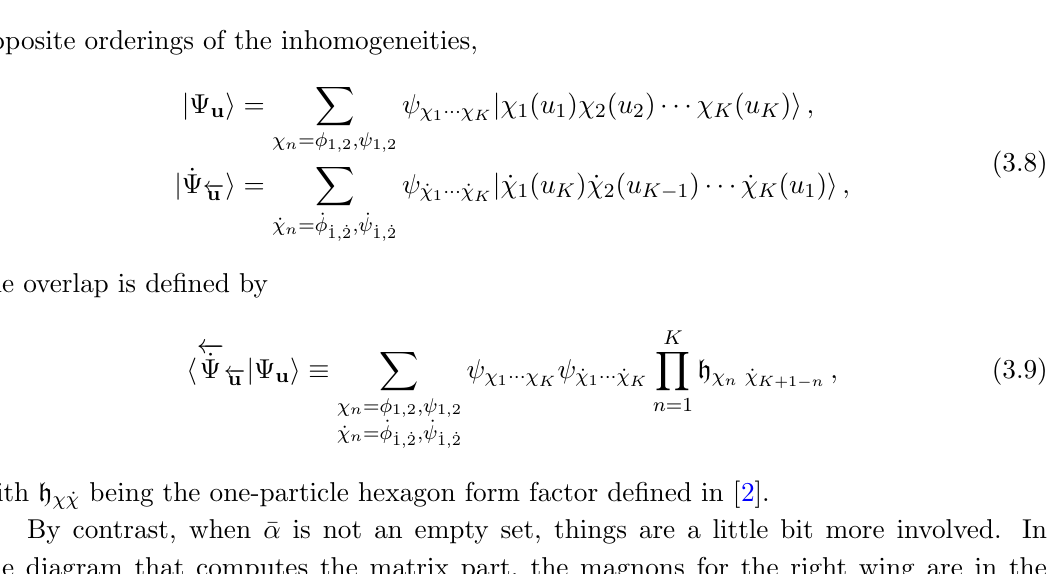
Figure 5. Matrix part for (cid:22) (cid:11) = ? : the magnons for the right wing are in a di(cid:11)erent order from 6 those in the wave function. To contract the wave function with the hexagon, we have to rewrite it using the \nested periodicity"